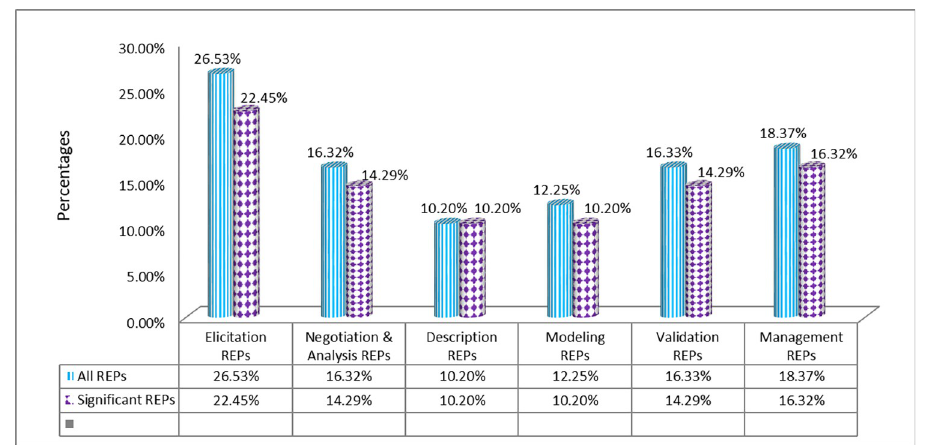
Fig 4. Percentages of the RE practices and significant RE Practices w.r.t phases of RE